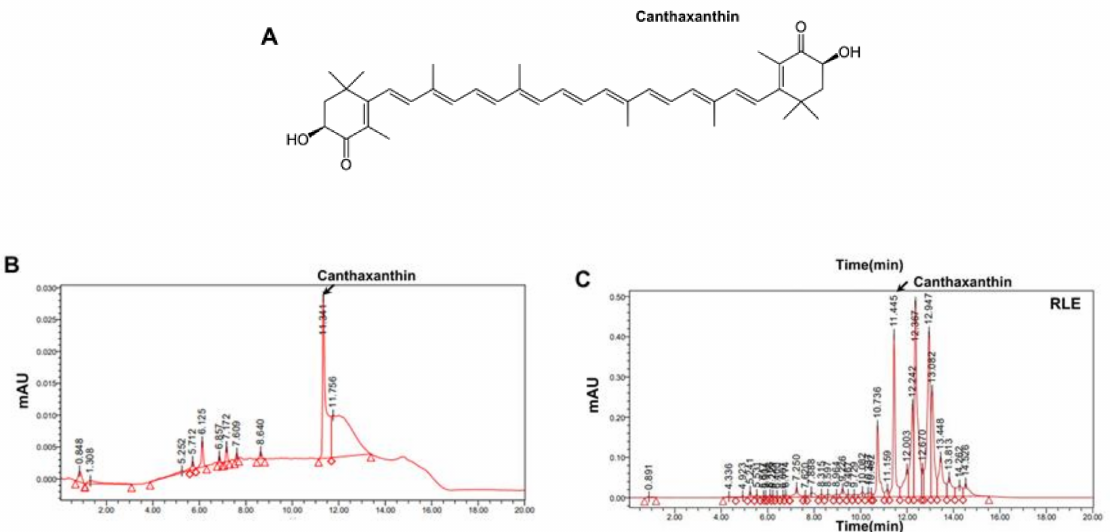
Figure 1. HPLC analysis of Ramie leaf extracts. ( A ) Chemical structure of canthaxanthin (CX). ( B ) Chromatograms of CX standard ( C ) and RLE analyzed for